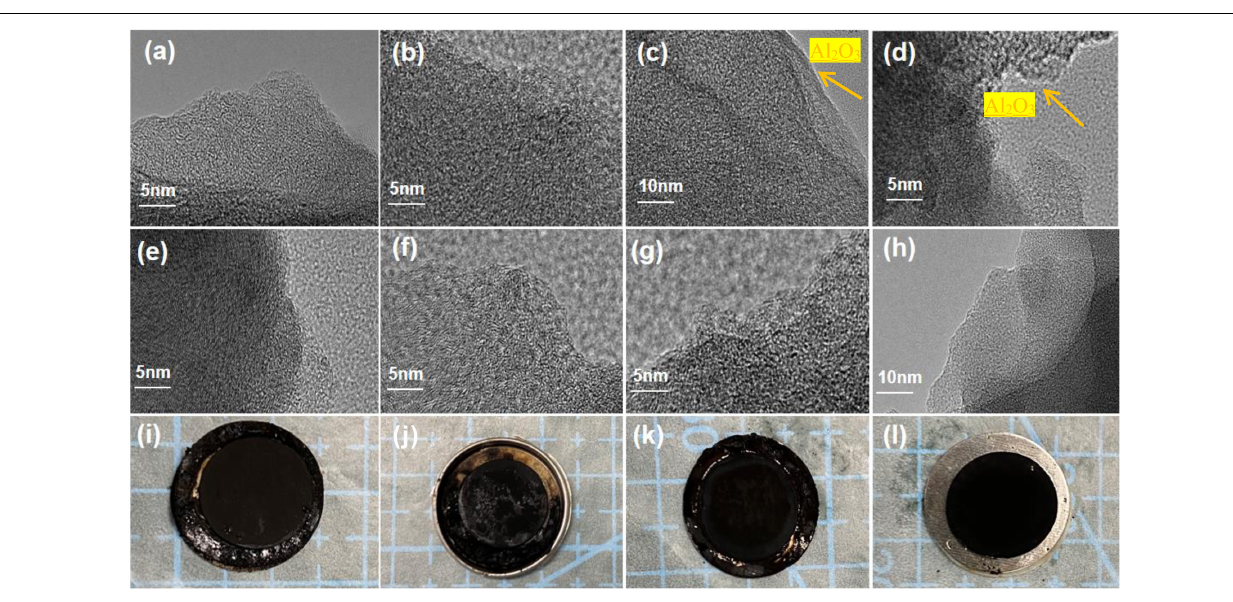
Frontiers in Energy Research |